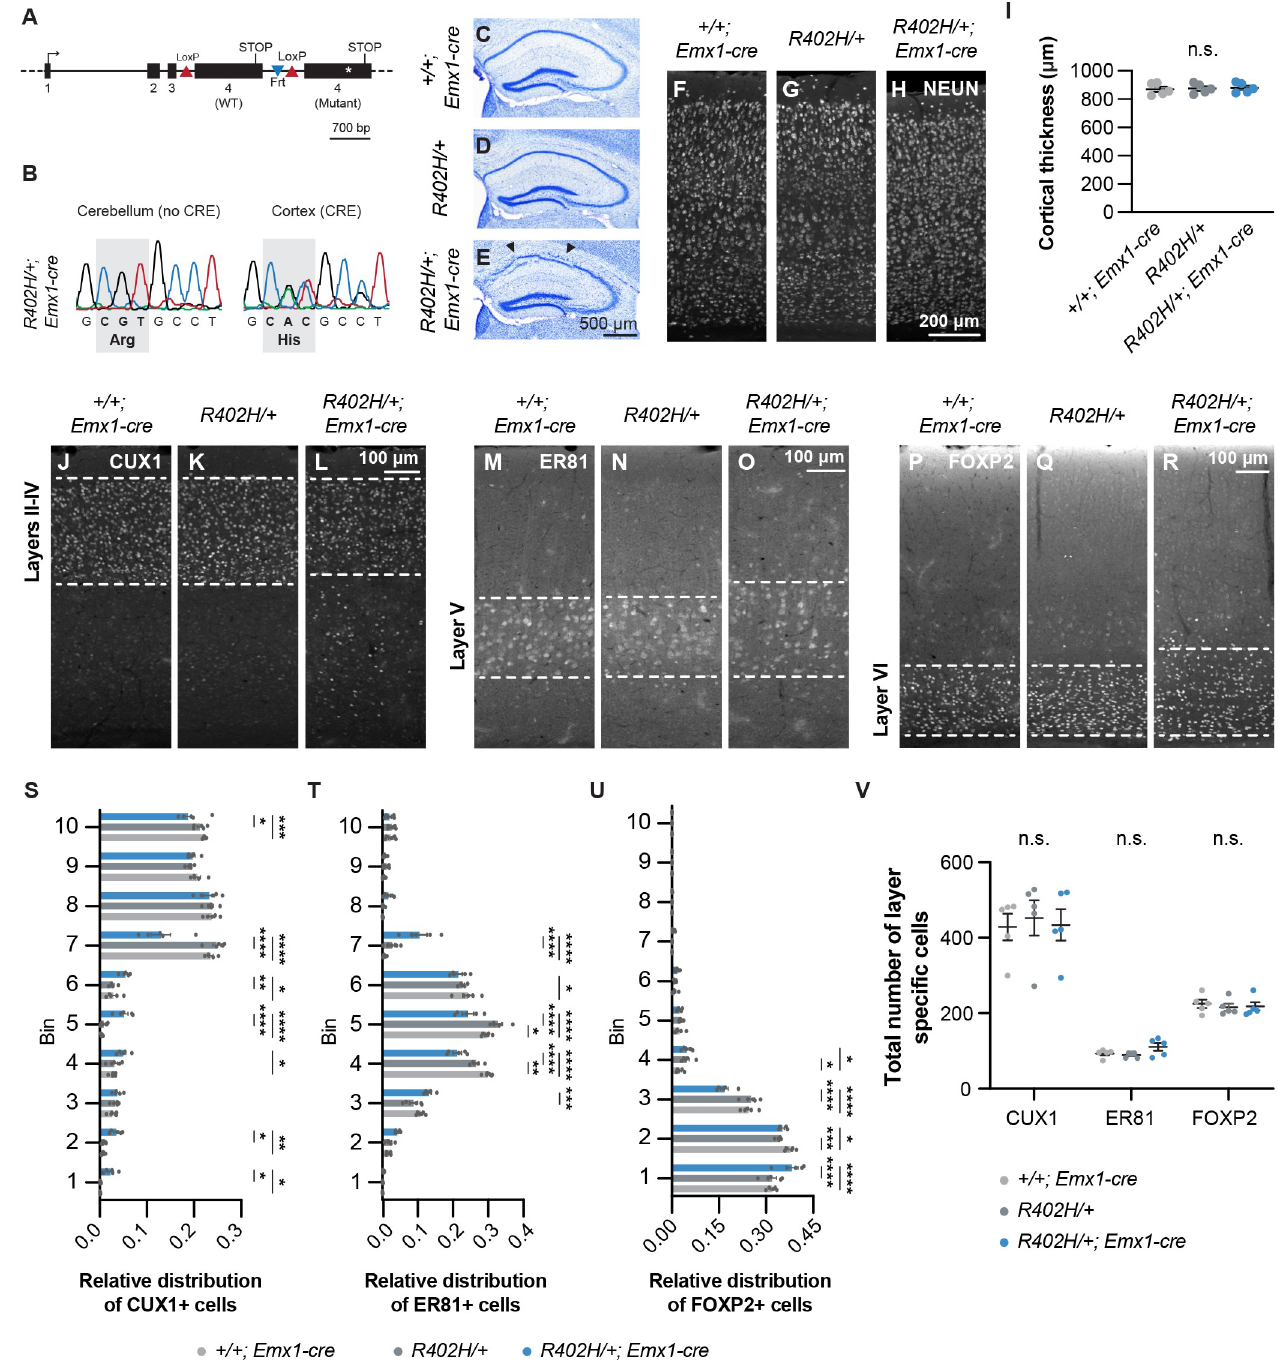
Fig 1. Laminar abnormalities in the hippocampus and cortex of R402H/+; Emx1-cre mice. (A) Schematic showing the targeting construct employed to generate R402H Tuba1a mice. The endogenous locus was replaced with two copies of exon 4, one flanked by LoxP sites and the other carrying the R402H mutation. In the presence of a Cre recombinase, the wild-type variant of exon 4 is excised, and the R402H mutant is expressed. (B) Sequencing traces generated from mRNA extracted from cortex and cerebellum of heterozygous R402H/+ animals that express Emx1-Cre in the dorsal telencephalon, but not in the cerebellum. The R402H mutation is only detected in the cortex. (C-E) Nissl stained sections of adult +/+; Emx1-cre , R402H/+ , and R402H/+; Emx1-cre animals. A fractured pyramidal cell layer in CA1 region (indicated by arrowheads) of the hippocampus is present in R402H/+; Emx1-cre animals (n = 5). (F-H) Representative coronal sections of the adult cortex stained with the pan-neuronal marker NEUN from +/+; Emx1-cre , R402H/+ , and R402H/+; Emx1-cre animals. (I) Quantification of cortical thickness reveals no significant difference between genotypes (n = 5, P > 0.05). (J-R) Cortical sections stained with layer- specific markers: CUX1 for layers II to IV, ER81 for layer V and FOXP2 for layer VI. (S-U) Relative distribution of CUX1 (S), ER81 (T) and FOXP2 (U)